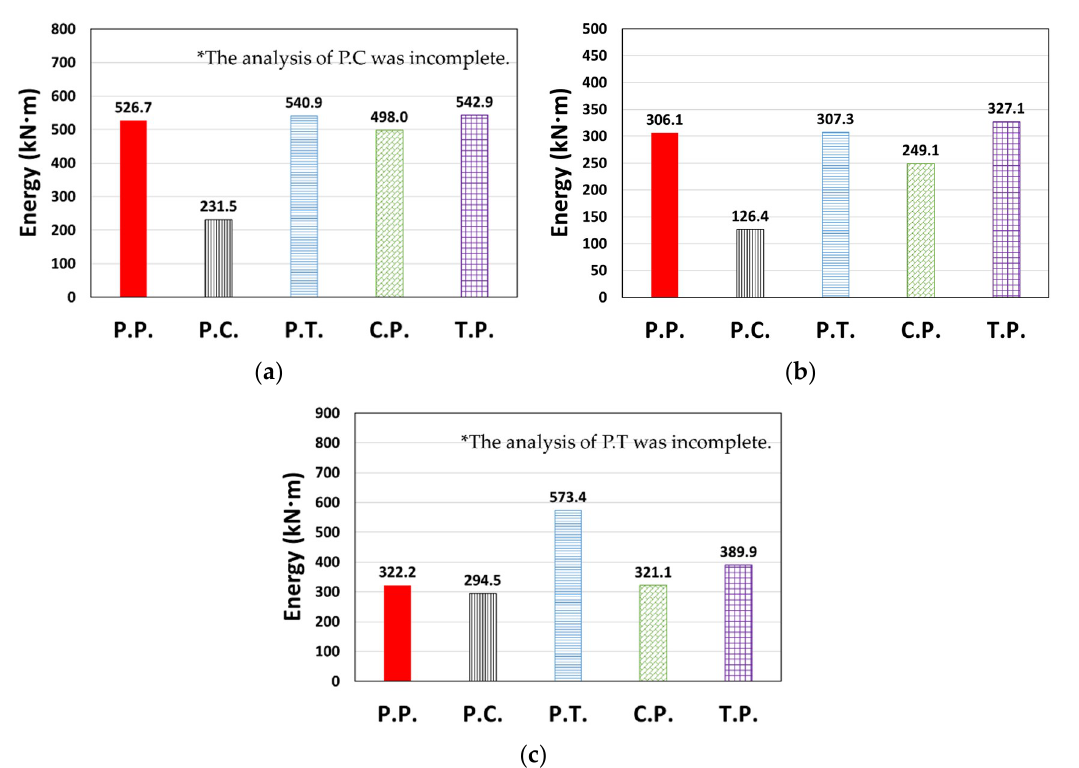
Figure 9. Cumulative dissipated energy: ( a ) Type 3 (Northridge, X-dir.), ( b ) Type 3 (Northridge, Y-dir.), and ( c ) Type 2 (El Centro, X-dir.).